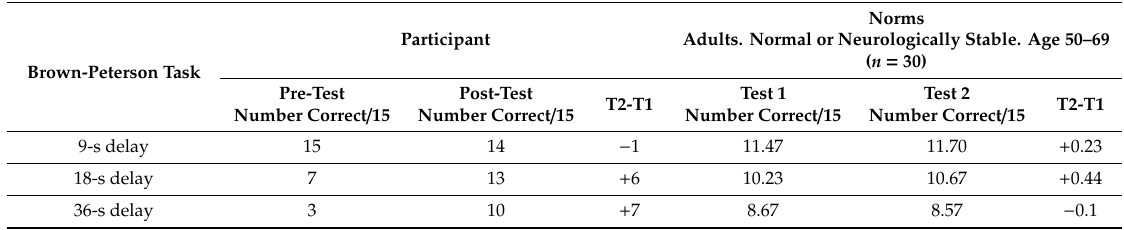
Table 3. Results of Brown-Peterson Task and Comparison to Normative